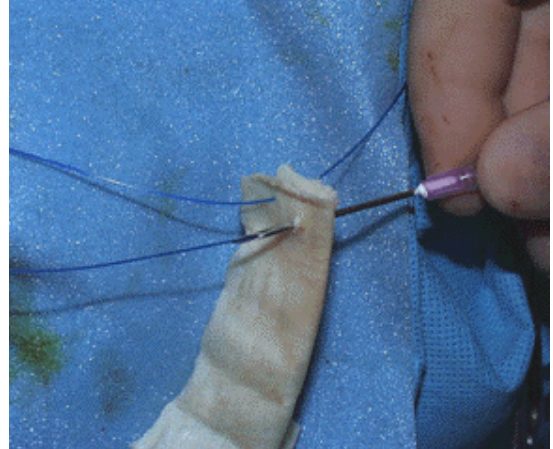
FIGURE 4 . A 4 x 7 cm segment of cadaveric fascia lata (folded lengthwise to 2 x 7 cm) is then passed into the tunnel and using an 18 gauge needle, the prolene suture ends are passed through the corners 5.0 mm from each end effectively creating a 6.0 cm sling. The sutures are then tied in position.